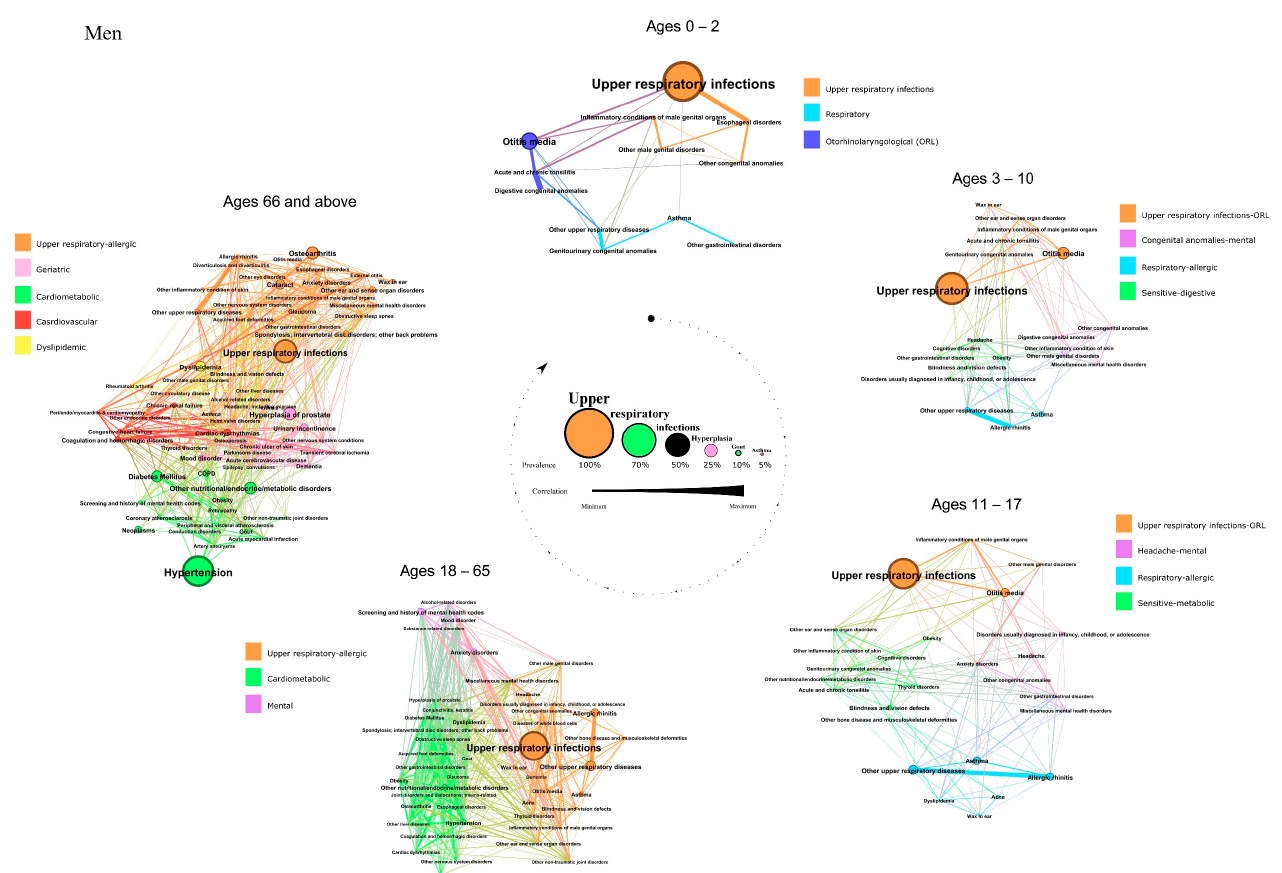
Figure 1. Comorbidity patterns in the networks of men with AD based on age. The diameter of each node and the label size are proportional to the disease prevalence. The width of each link is proportional to the correlation between disease. The colors of the nodes correspond to different patterns.